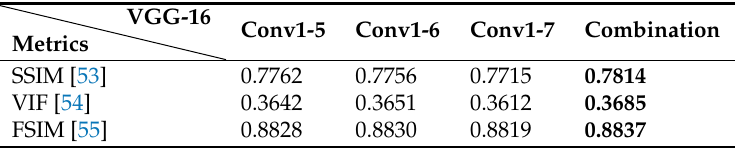
Table 5. Average FR-IQA values of poor-lighted face images processed by our methods trained by various loss items on the MultiPIE dataset.